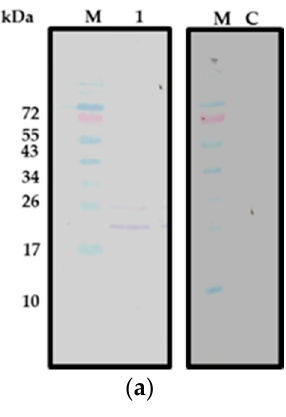
Figure 1. Cont. Figure 1.